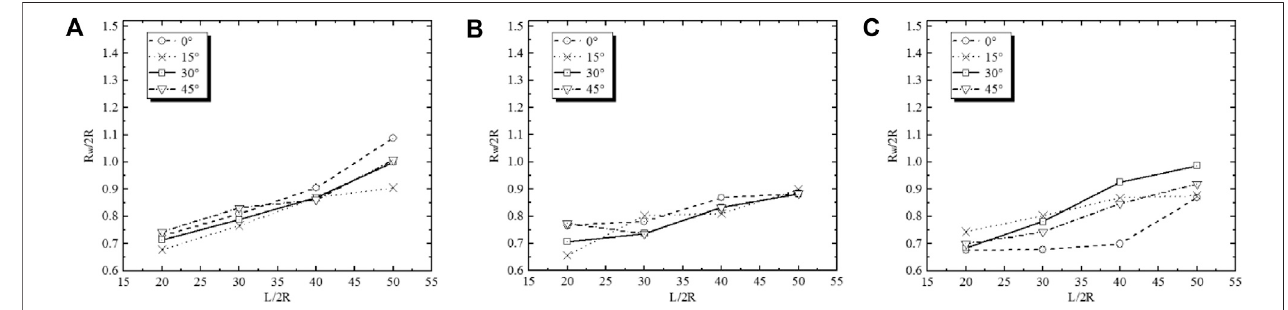
FIGURE 11 | Crossplots of dimensionless parameters (R w /2R and L/2R) for the determination of optimal measuring windows in these three double-crack DEM- DFN models as shown in Figure 9 . (A) Distant double cracks. (B) Collinear double cracks. (C) Stacked double cracks.